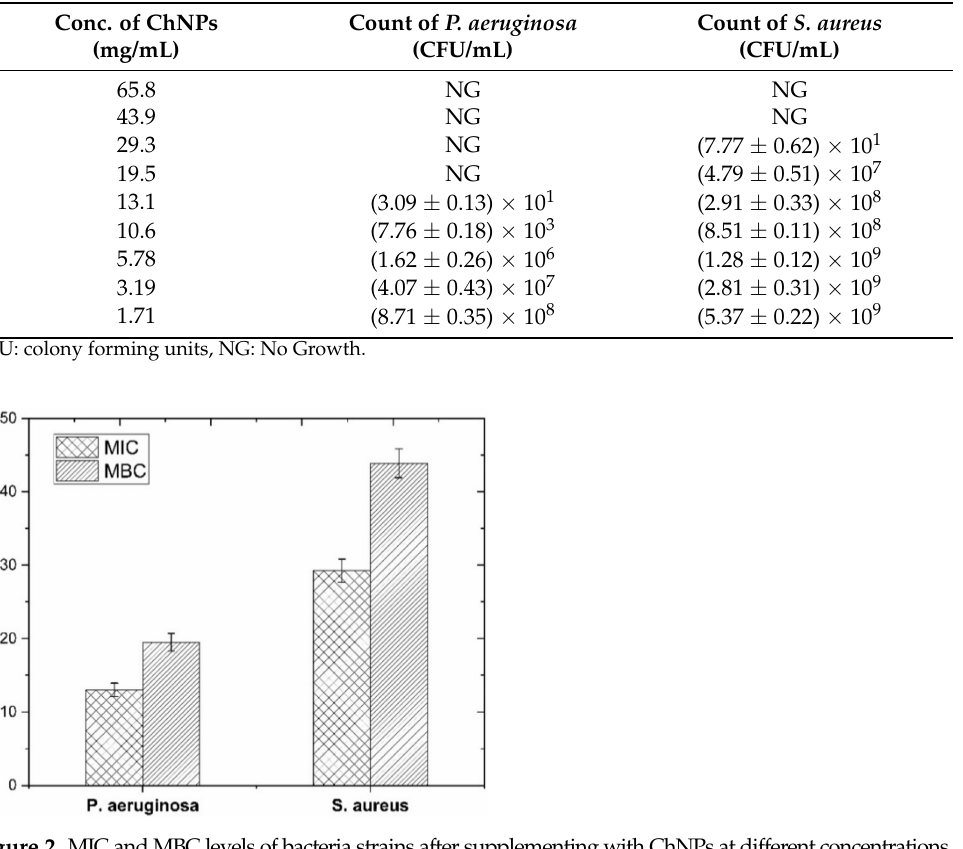
Table 1. List of P. aeruginosa and S. aureus counts (CFU/mL ± SE) under supplement of ChNPs at different concentrations.